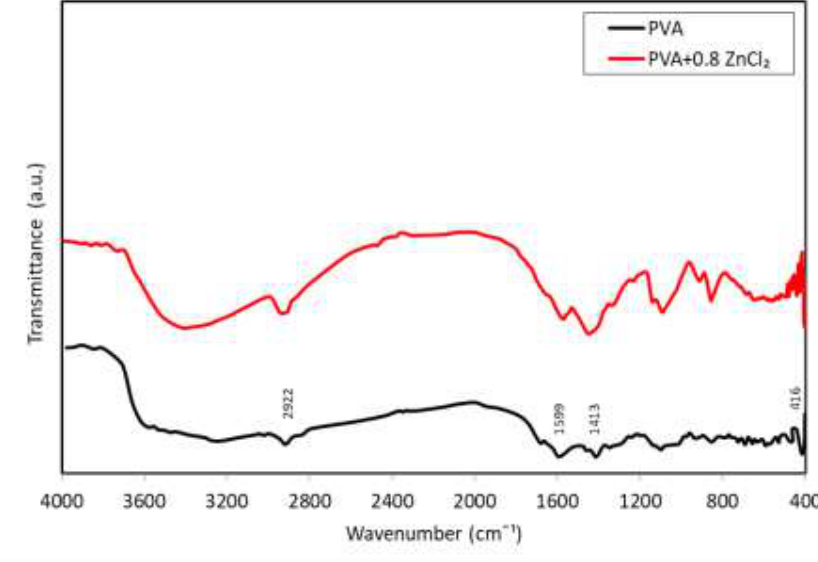
Figure 4: FTIR spectra of PVA and Zn-PVA (0.6 g of ZnCl 2